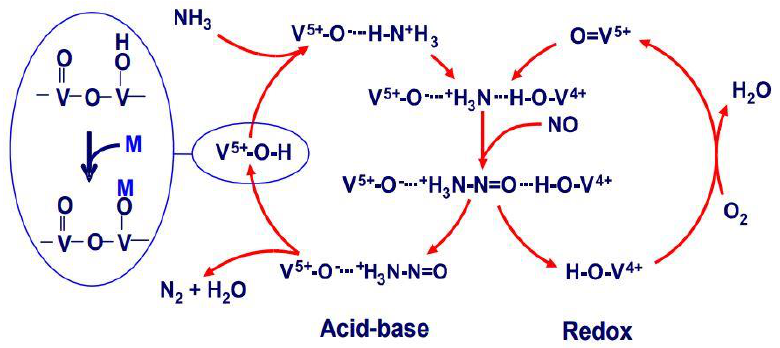
Figure 9. Denitration reaction mechanism based on standard SCR reaction path [52].